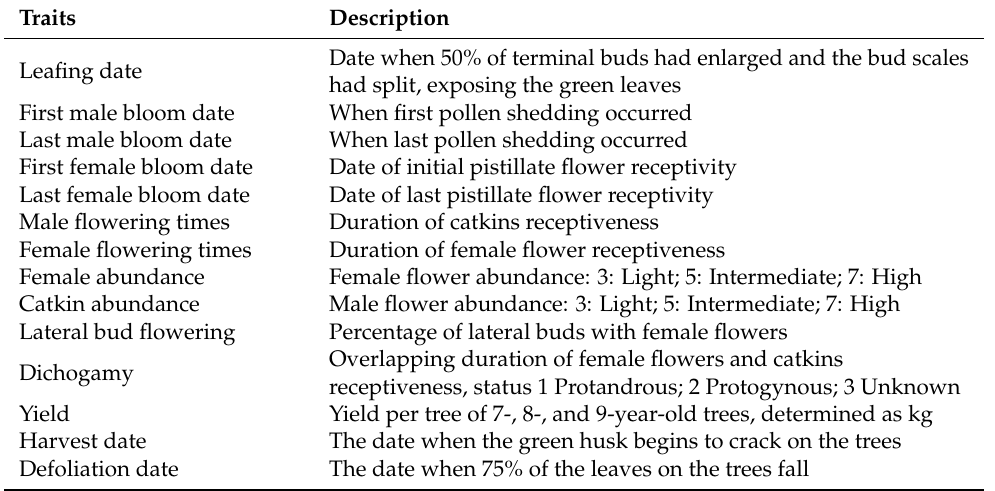
Table 1. Description of the phenological traits.